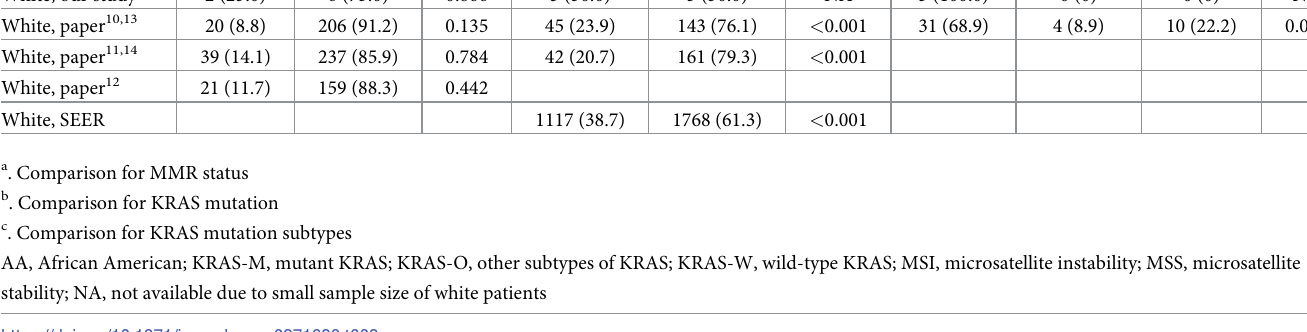
mutations tested, codon 12 mutation was more common in AA than in white patients (85.2% vs. 68.9%, p = 0.019) (Fig 1; Table 2). Analysis of conventional CRC locations (right and left) and our proposed CRC locations (proximal/distal and middle) showed that AA patients had significantly higher frequency of KRAS mutations than white patients both in left colon (51.9% vs. 10.7%, p < 0.001) and in proximal/distal colon (55.9% vs. 26.4%, p < 0.001) (S3 For distribution of MMR status, there is no significant difference between AA and white patients, after comparing AA data with white patient data from published literatures (Table 2).